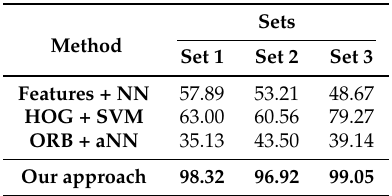
Table 6. Comparison among the F 1 (%) measure obtained from the best approach of our architecture (Xception NC normalized with (cid:96) 2 and with kNN) and several traditional feature extraction methods. The best result for each set is shown in bold